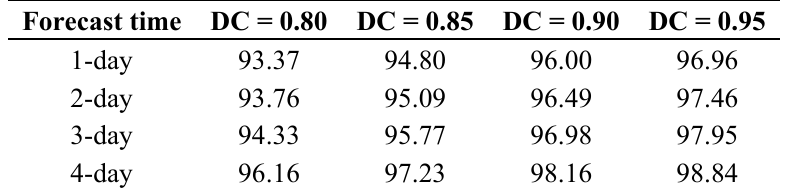
Table 4. The simulated power generation for different forecast time and different forecast accuracy in 2009 (TWh).